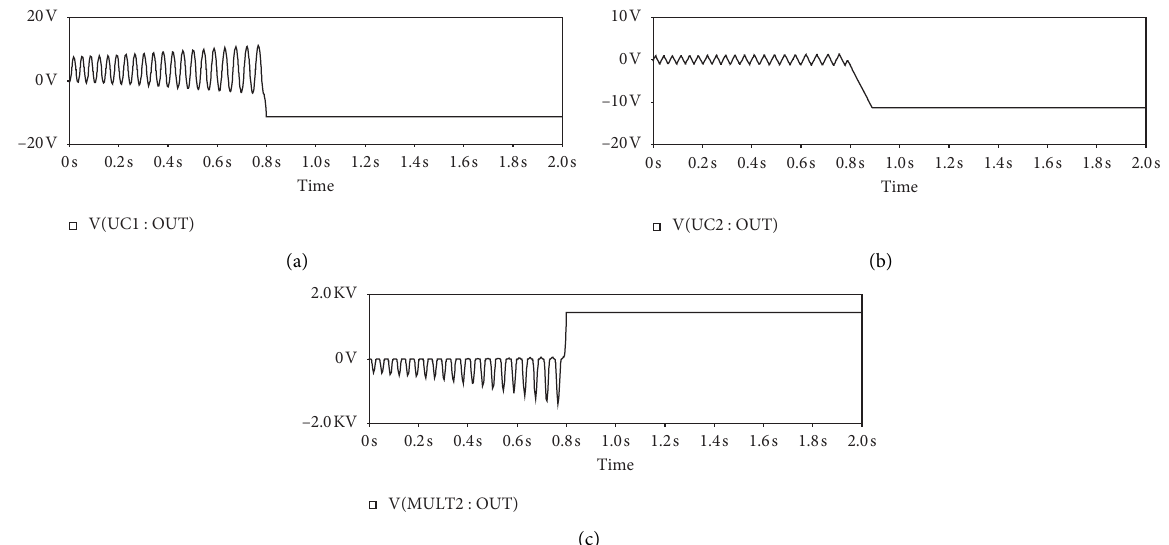
Figure 7: Output voltages of (a) amplifier with capacitor C